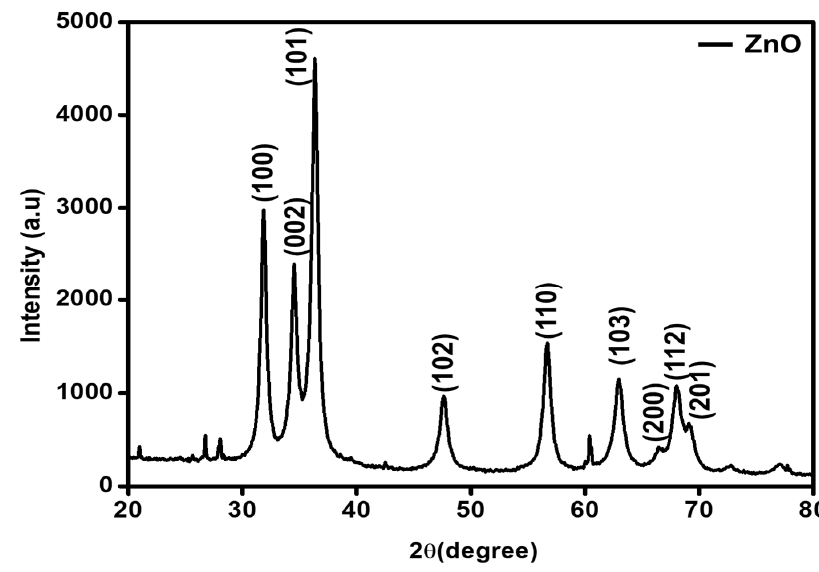
Figure 2. XRD diffractogram of as-synthesized ZnO-GS NPs. As-synthesized ZnO-GS nanoparticles were subjected to FT-IR spectral analysis be- tween the frequency range of 400–4000 cm − 1 and the obtained transmittance data are portrayed in Figure 3. The spectral data confirm the formation of ZnO nanoparticles with a sharp dip below the frequency of 500 cm − 1 , which is, according to earlier studies, related to ZnO nanoparticles [26]. However, the presence of other vibrational peaks—apart from the peak 415 cm − 1 —such as the broad peak at 1064 cm − 1 , indicates the presence of absorbed CO 2 , possibly from residues of cow dung, as the combustion fuel [27,28].